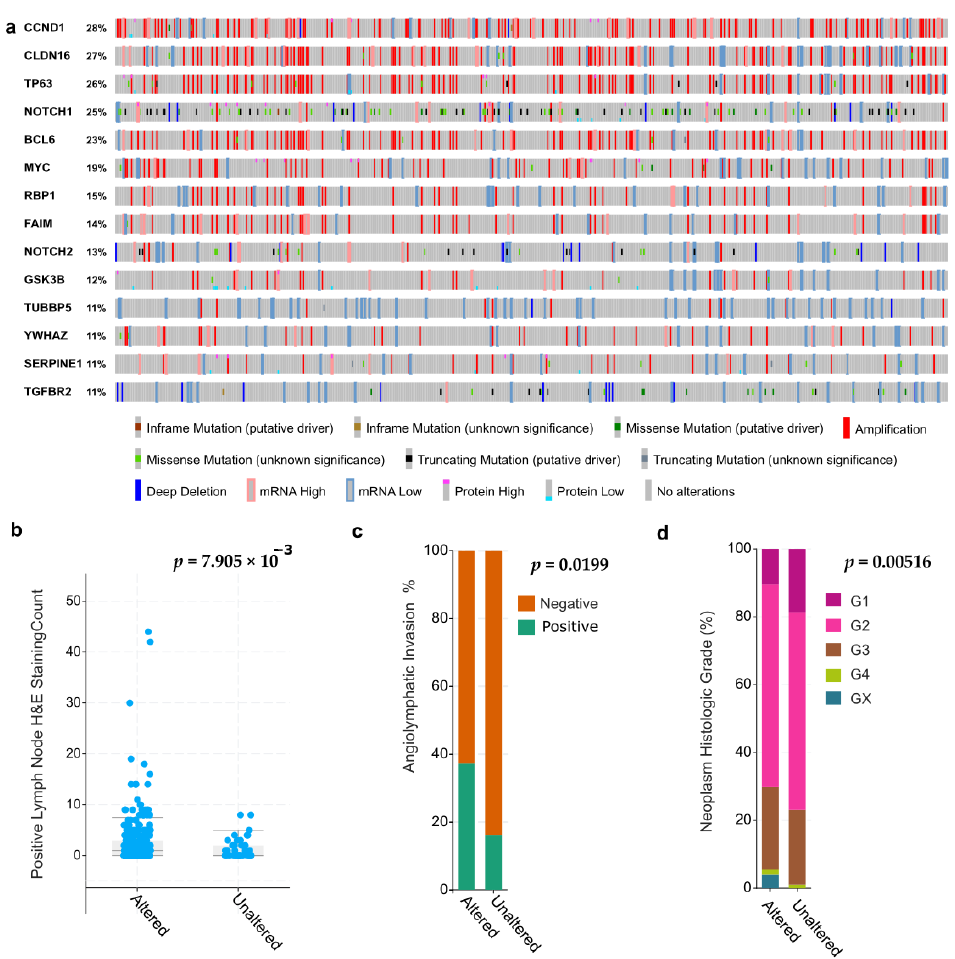
Figure 3. Analysis of most frequently altered NOTCH and EMT-related genes in head and neck squamous cell carcinomas (HNSCCC). ( a ) Mutation and gene expression profiles for 12 target genes associated with both Notch signaling and EMT in the cBioPortal genomic database (sorted by patient number, not mutations). Indicated are mainly genomic amplifications, deletions, and point mutations, followed by mRNA and protein overexpression across 530 HNSCC tumor samples from the “Firehose legacy” sequencing project. ( b ) Number of patients with positive lymph nodes (left) is increased for tumors that harbor genetic alterations in the 12 Notch/EMT genes show above. ( c ) Patients with a high degree of genetic changes in Notch/EMT signature genes also show a larger proportion of tumors with angiolymphatic invasion, or penetration of tumor cells into lymph vessels in the tumor periphery. ( d ) Patients with large numbers of Notch/EMT genes mutated further show a larger likelihood to develop high grade tumors (G3 and G4), with enhanced invasive properties.